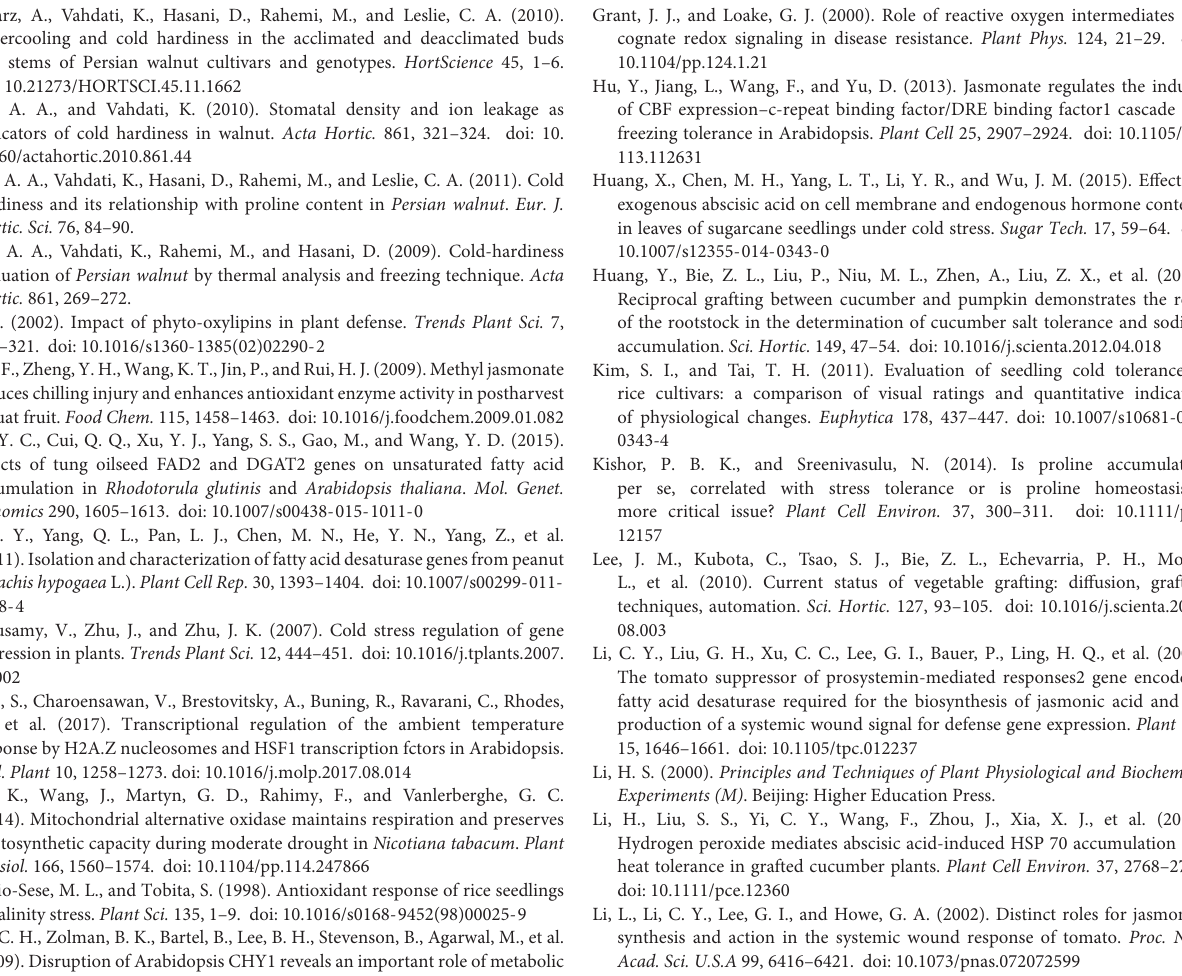
Supplementary Table 7 | Top 10 GO enrichment categories for 390 upregulated DEGs in pumpkin leaves under chilling stress. Supplementary Table 8 | KEGG enrichment of 390 upregulated DEGs in pumpkin leaves.